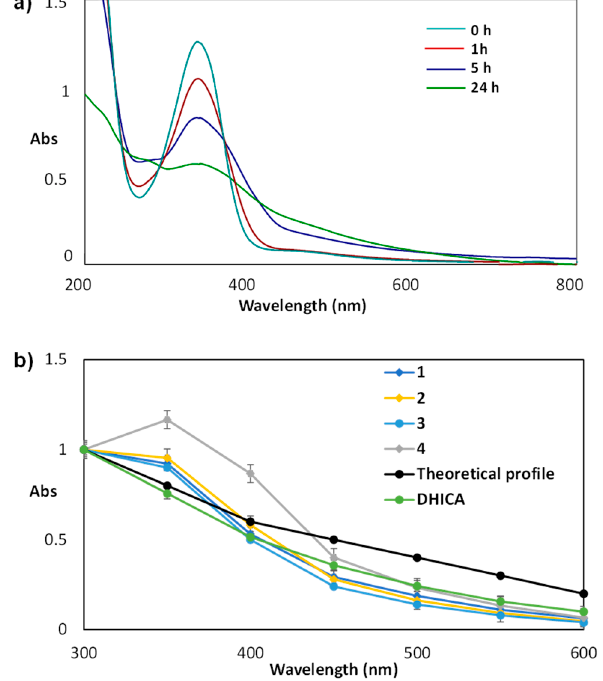
Figure 3. ( a ) UV–Vis spectrum of the course of the aerial oxidation of 1 over time; ( b ) relative absorbance of the oxidation mixtures of all the synthesized amides and DHICA at 24 h reaction time against the theoretical monotonic profile. Reported are the mean ± SD values of at least three experiments. (Values normalized against the absorbance at 300 nm for each mixture).